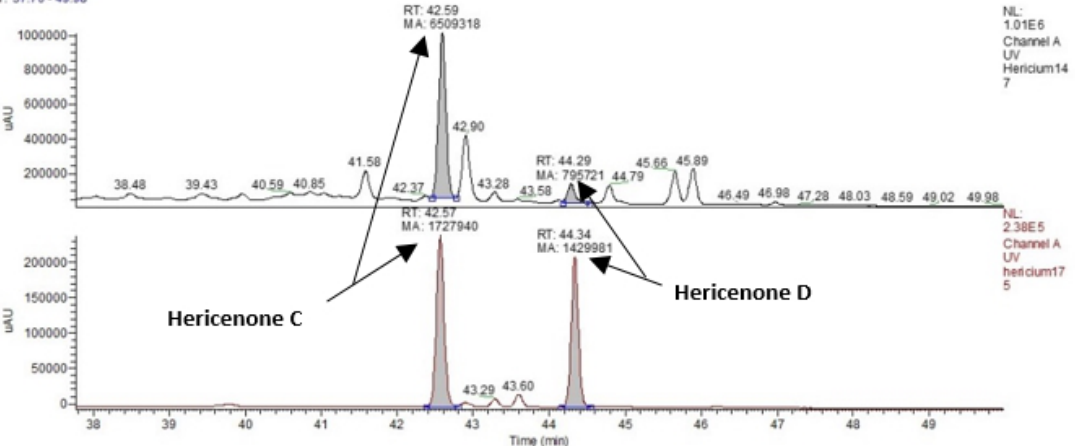
Figure 7. UV (Ultra Violet) traces of He1 sporophore (top) and Hericenone C (Rt 42.57) and D (Rt 44.34) standards (bottom). Peak areas corresponding to Hericenone C and D are pointed out.